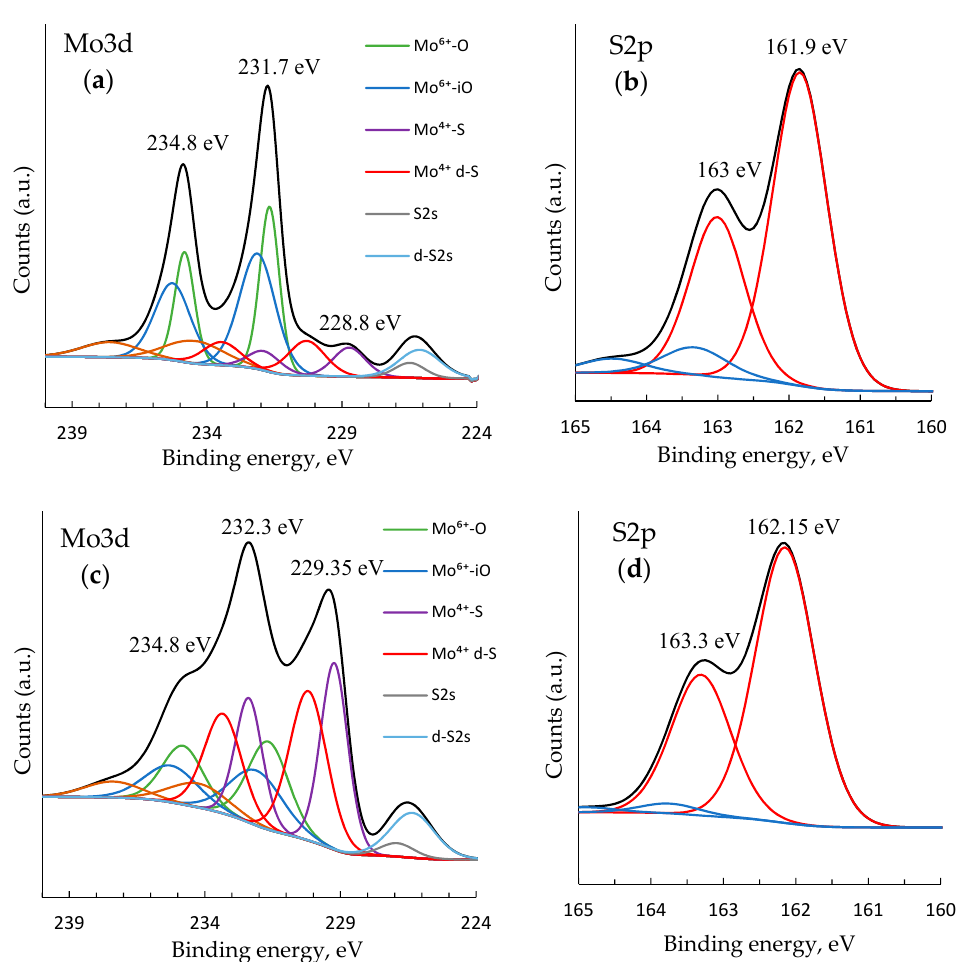
Figure 3. XPS spectra and fitted peaks of MoS 2 films, electrodeposited on copper foams: ( a , b ) without NaH 2 PO 2 ; and ( c , d ) with NaH 2 PO 2 .